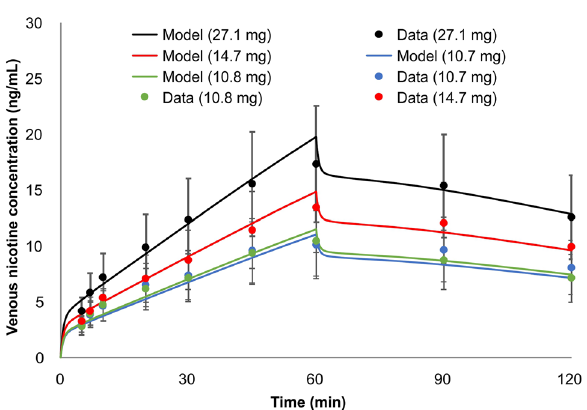
Figure 18. Simulation of the nicotine venous plasma concentration in 20 subjects during and after a single use of MST. Four separate uses were administered including two loose snus (27.1 mg/plug, black and 10.8 mg/plug, green) and two pouched snus (14.7 mg/pouch, red and 10.7 mg/pouch, blue). Plugs remained in place for the first 60 min of the study 37 . Error bars represent one standard